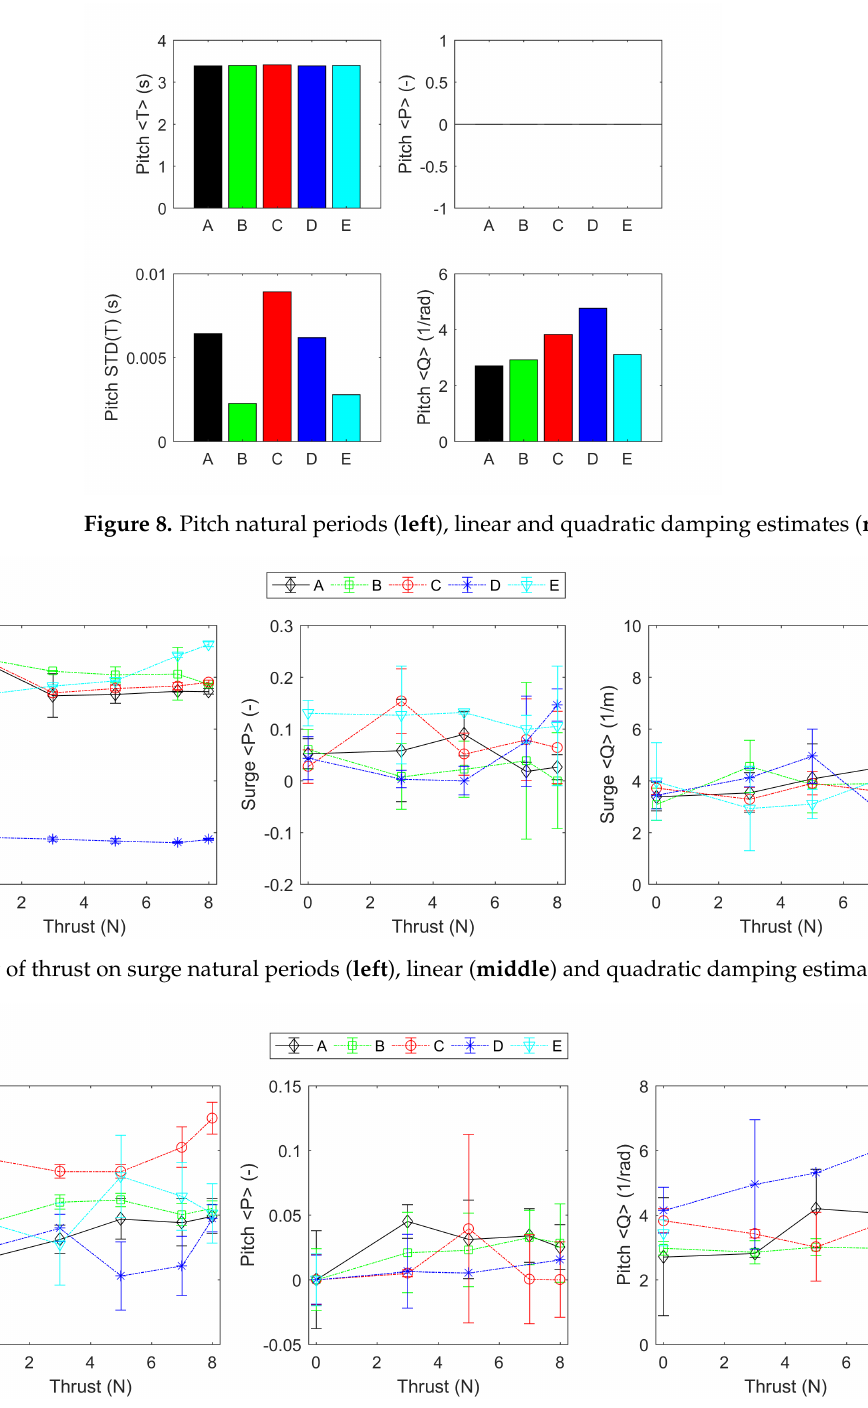
Figure 10. Effect of thrust on pitch natural periods ( left ), linear ( middle ) and quadratic damping estimates ( right